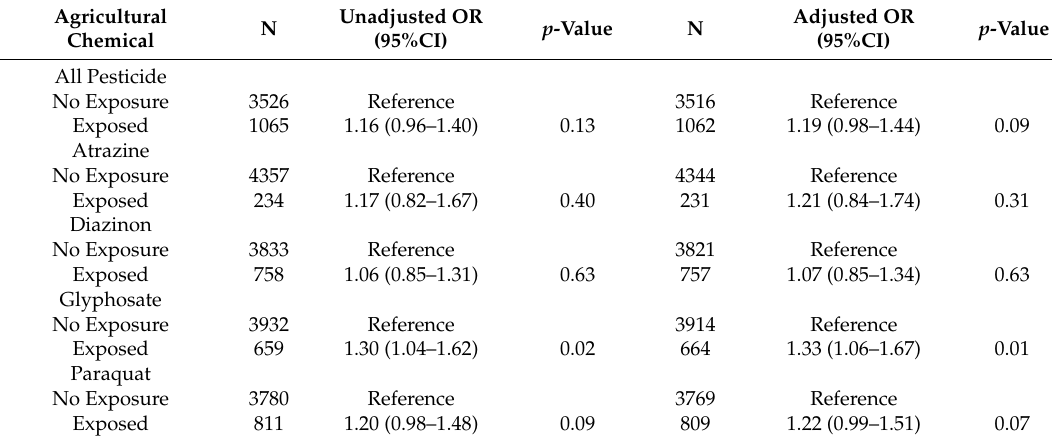
Table 2. Unadjusted and adjusted odds ratios of premature mortality by PD from exposure to individual agricultural